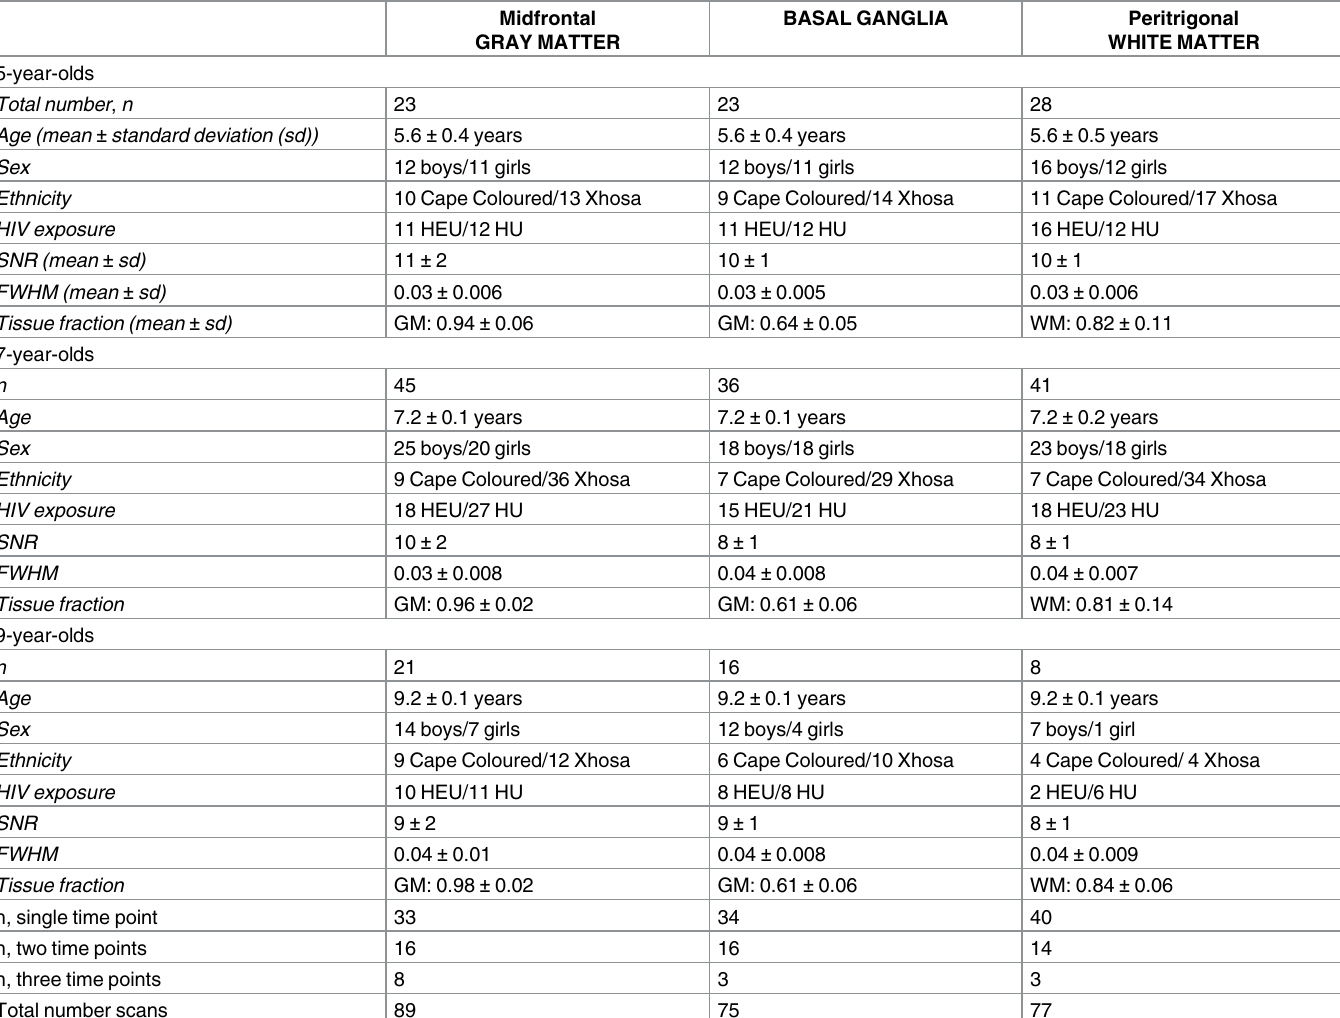
Table 2. Characteristics of